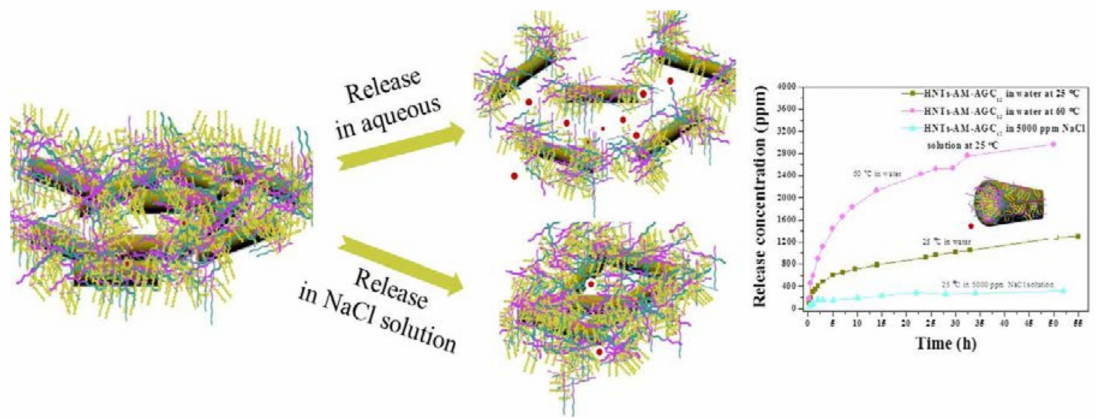
Figure 6. Scheme of methenamine release from nanocomposite at different